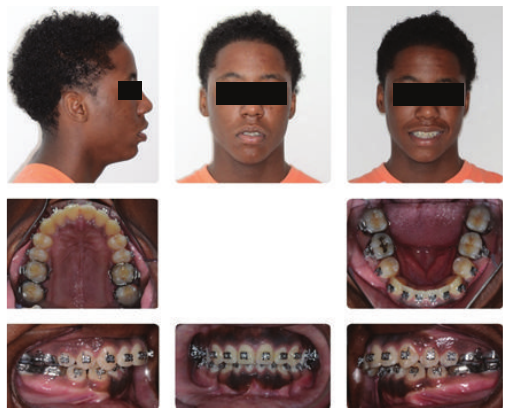
Figure 15: Stage 2: Presurgical Composite.